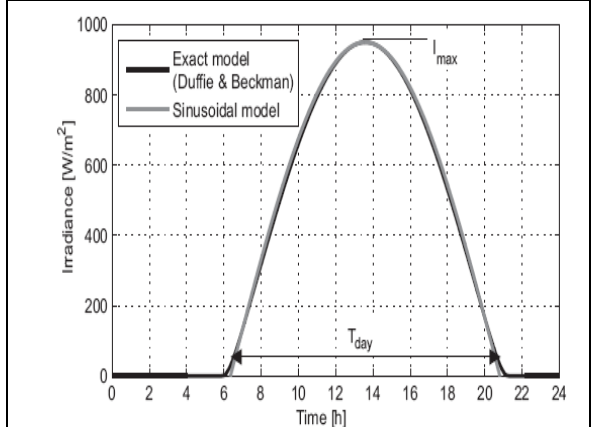
Figure 3. Approximation of irradiance as a